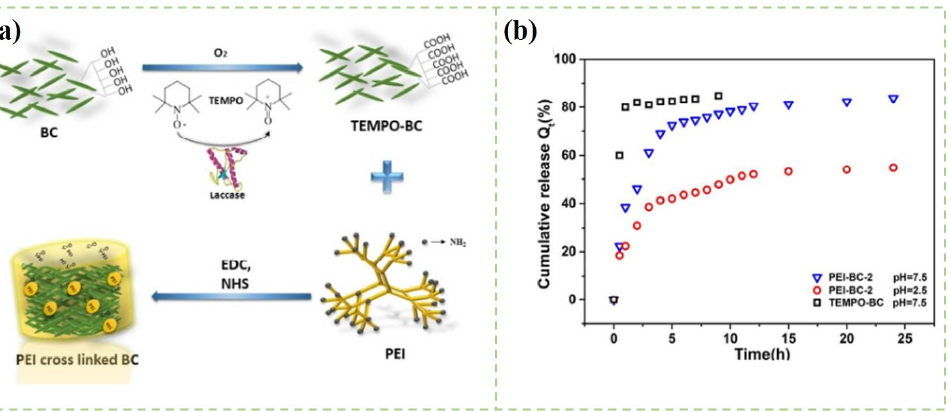
Figure 6. ( a ) Schematic illustration of the preparation of the PEI-BC composite aerogels; ( b ) The cumulative release curves of aspirin [128].